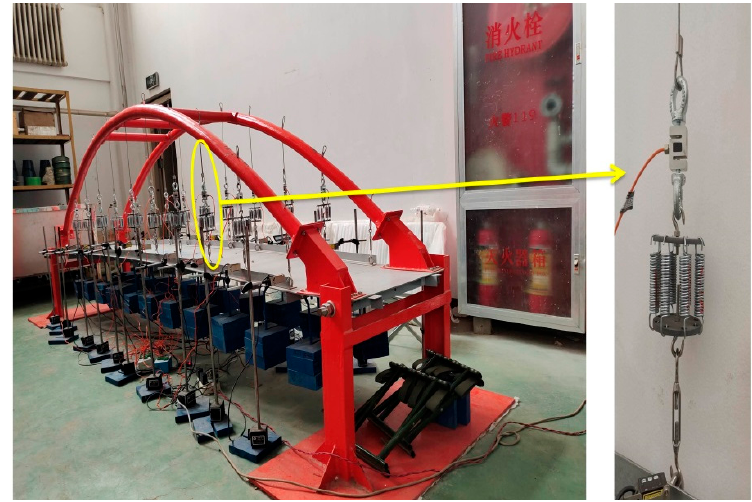
Figure 8. Test model diagram of the through-arch bridge.